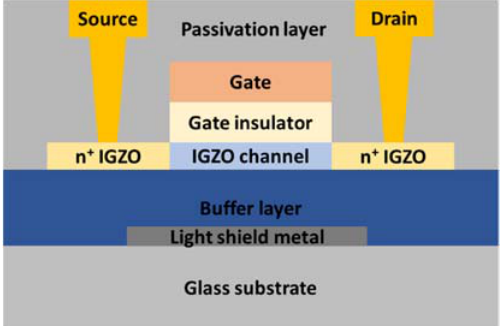
Figure 1. Device structure of the fabricated SA-TG coplanar IGZO TFT.